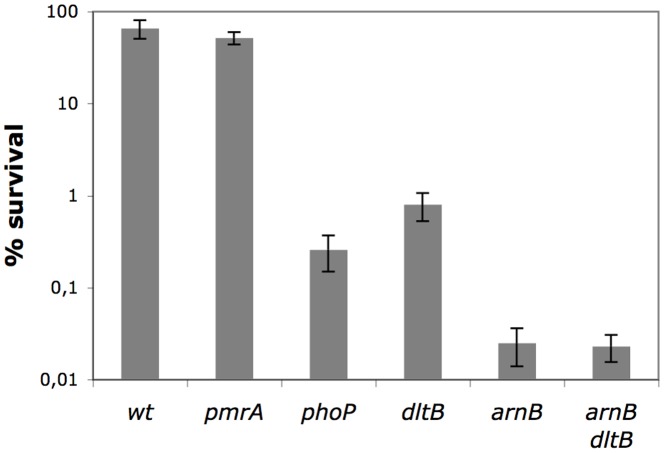
Survival of various mutants to polymyxin.Wild type and various mutants in genes involved in resistance to AMP (phoP, pmrA, dltB, arnB) were incubated in the presence of 1 µg ml−1 polymyxin for 1 h. Samples were diluted and plated on LB agar plates to assess bacterial viability. Survival values are relative to the original inoculum. Data correspond to mean values of three independent experiments.